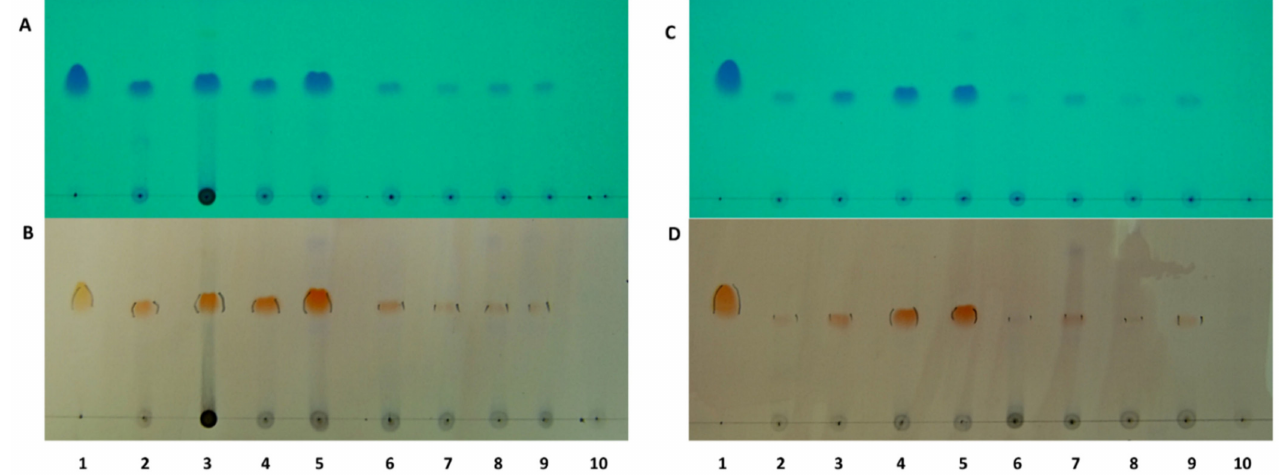
Figure 1. Localization of rhodomyrtone in methicillin-resistant Staphylococcus aureus (EMRSA-16) ( A , B ) and ATCC 29213 ( C , D ) as determined using the thin-layer chromatography technique. The bacterial cells were treated with rhodomyrtone at 4 × MIC for 1–4 h. Rhodomyrtone was visualized under UV absorption at 254 nm ( A , C ) and after spraying with anisaldehyde/H 2 SO 4 and heating ( B , D ). Lanes 2–5 are fractions from the cell wall and cell membrane of rhodomyrtone- treated cells, whereas lanes 6–9 are fractions of cytoplasm from the treated cells. One-percent DMSO was used as a negative control. Lane 1: reference rhodomyrtone; lanes 2 and 6: treatment for 1 h; lanes 3 and 7: treatment for 2 h; lanes 4 and 8: treatment for 3 h; lanes 5 and 9: treatment for 4 h; lane 10: negative